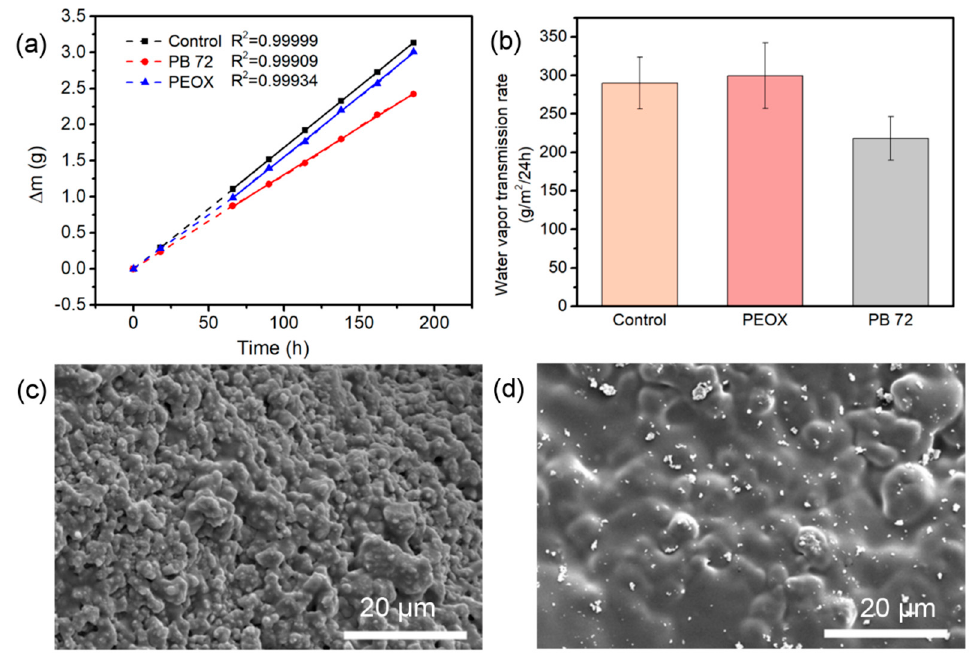
Figure 7. ( a ) The curves of weight change of the set in each 24 h with test time; ( b ) The water vapor transmission rate of the untreated samples, PEOX treated samples, and PB 72 treated samples for 120 h; ( c , d ) SEM images of the morphology of the surface of PEOX treated sample and the PB 72 treated sample after the test, respectively.